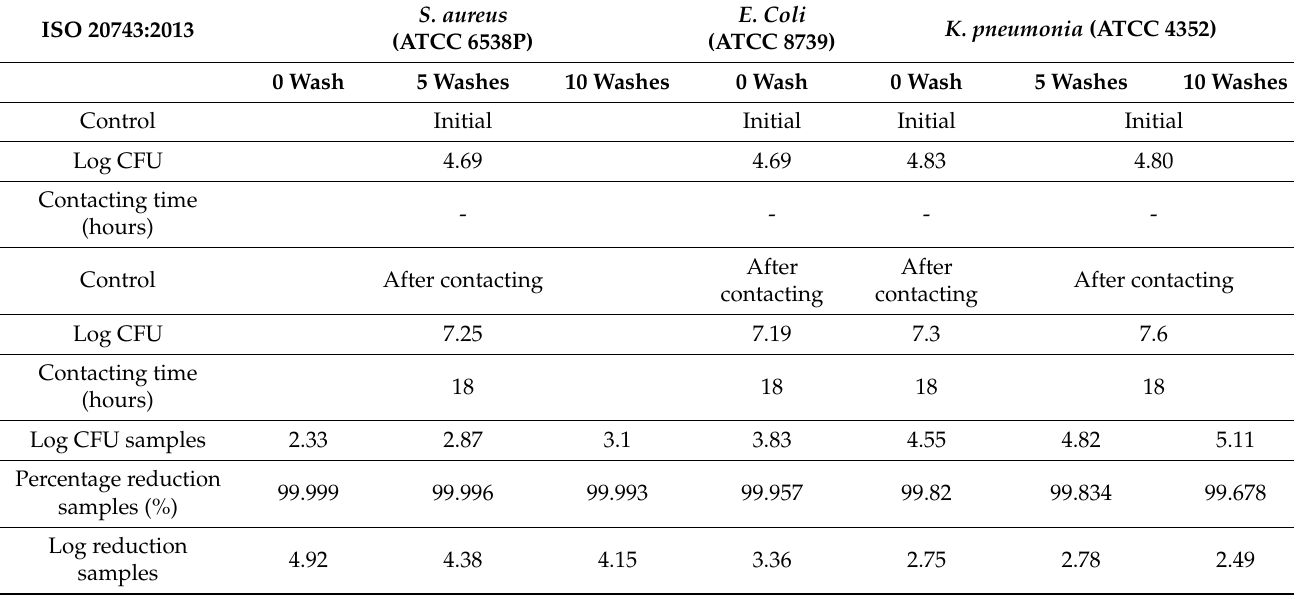
Table 5. Antibacterial reduction rate of PLA NF filter media containing manuka triketone (5 wt.%) against S. aureus (ATCC 6538P), E. coli (ATCC 8739). and K. pneumoniae (ATCC 4352) tested ac- cording to ISO 20743:2013 [43]. Reusability following 5 and 10 laundering cycle according to ISO 6330:2013 [49] and ISO 20743:2013, was confirmed for the PLA NF filter media when tested against S. aureus (ATCC 6538P) and K. pneumoniae (ATCC 4352).